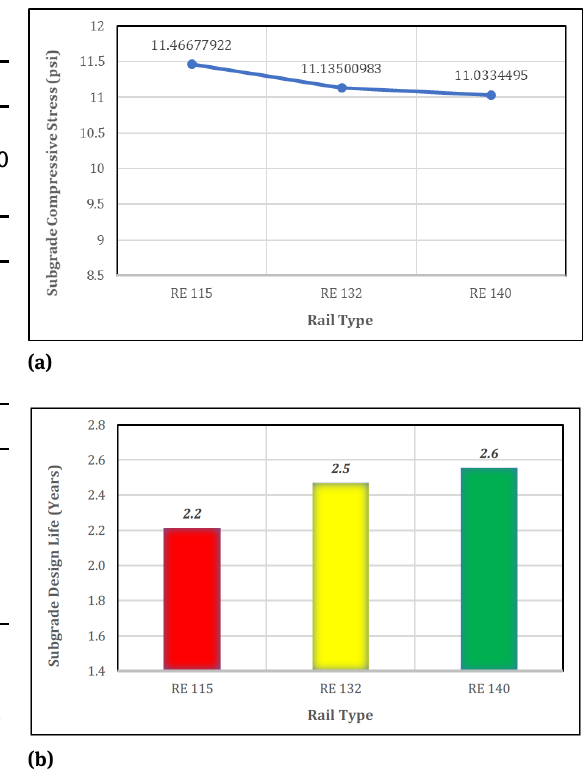
Figure 9: Effect of rail type on subgrade compressive stress (a) and on subgrade design life (b) in granular rail